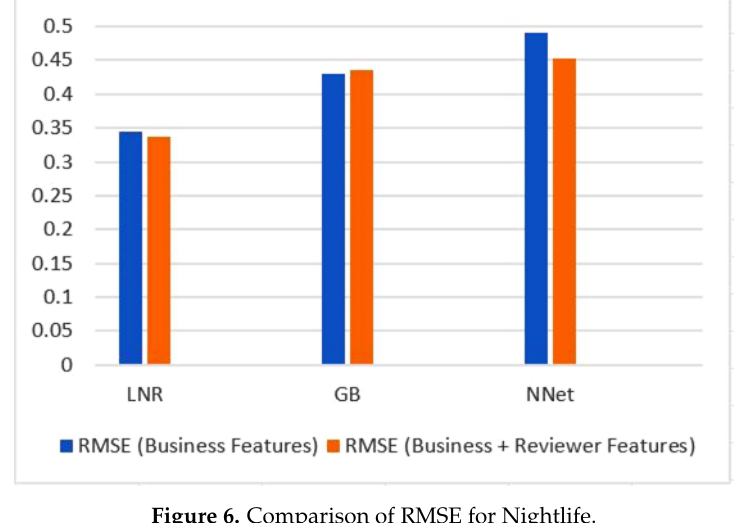
Figure 6. Comparison of RMSE for Nightlife.